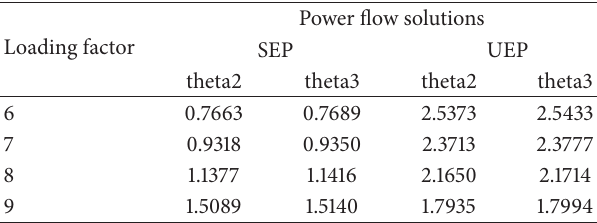
Table 4: Power flow solutions on different loading